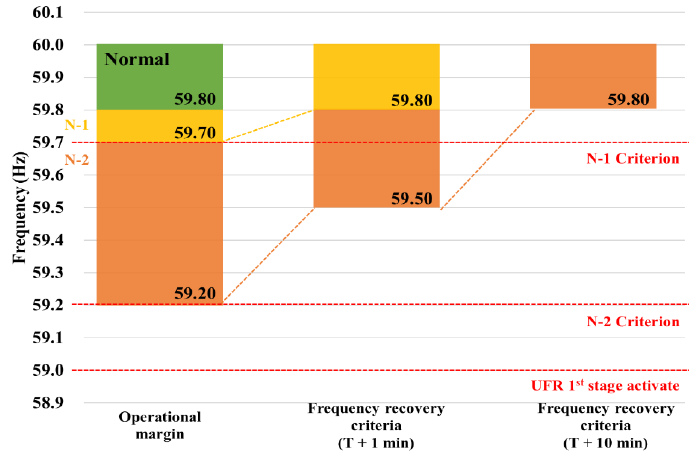
Table 1. Reserve criteria for frequency ancillary service in the Korean power system, Adapted from Ref. [33].